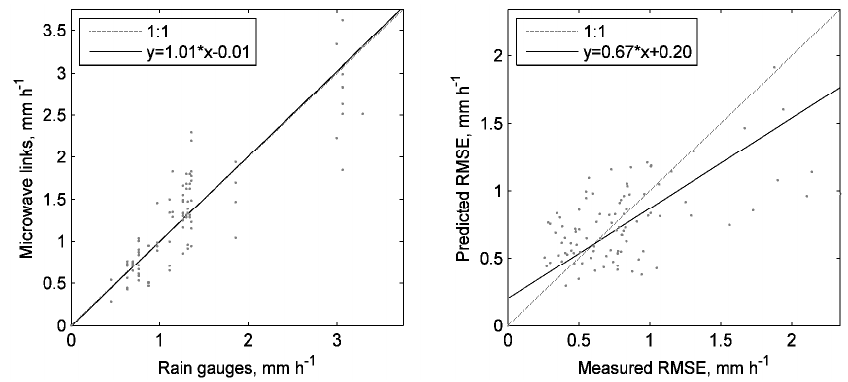
Fig. 10. Scatter plots of the total microwave measured rainfall vs. rain gauge measurements (left) and Spatial+Link estimates of the predic- tion error vs. measured error (right) for all link-gauge combinations, 1t =60min. The method of total least squares, assuming uncertainties in both independent and dependent variables (Krystek and Anton, 2007) has been used to draw regression lines.